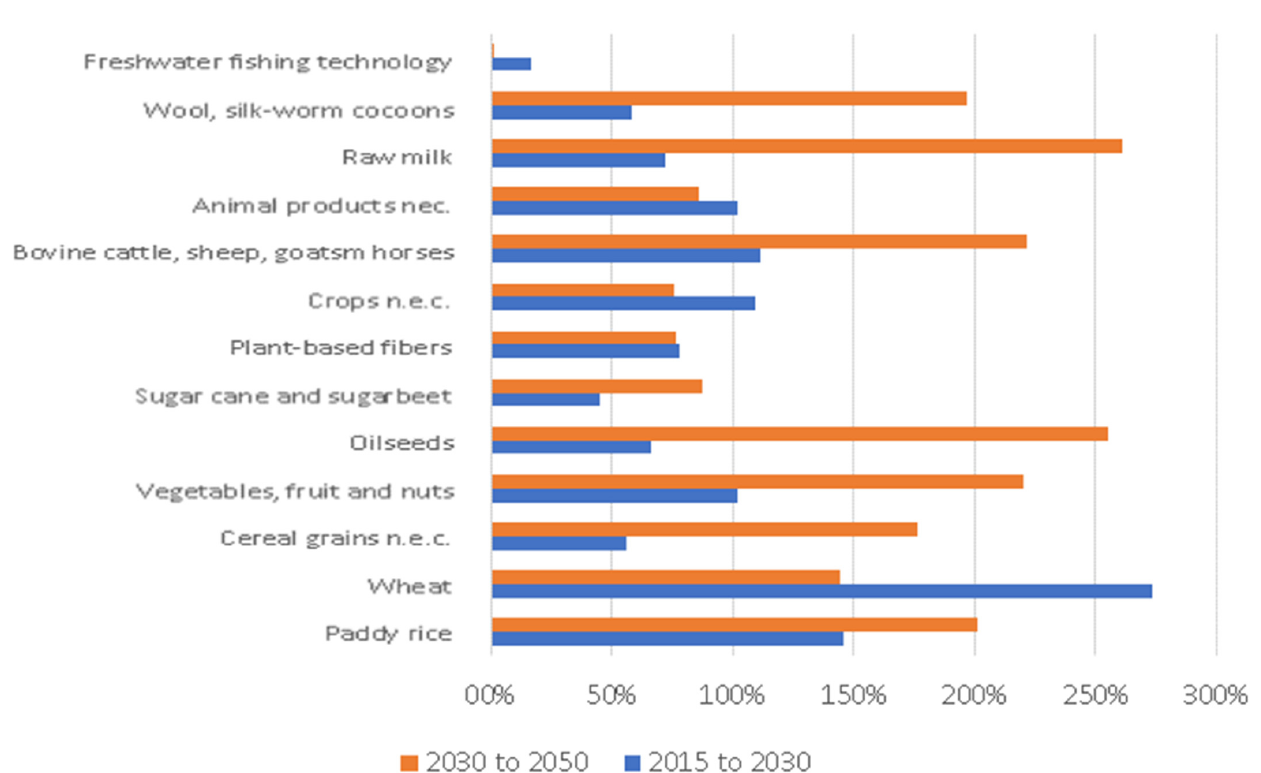
Figure 2. Change in agricultural production results with the WTM/RCOT based on the comparative advantage of SSP3 “inequality”. Note: n.e.c. = not elsewhere classified. Source: own elaboration based on the WTM/RCOT results.